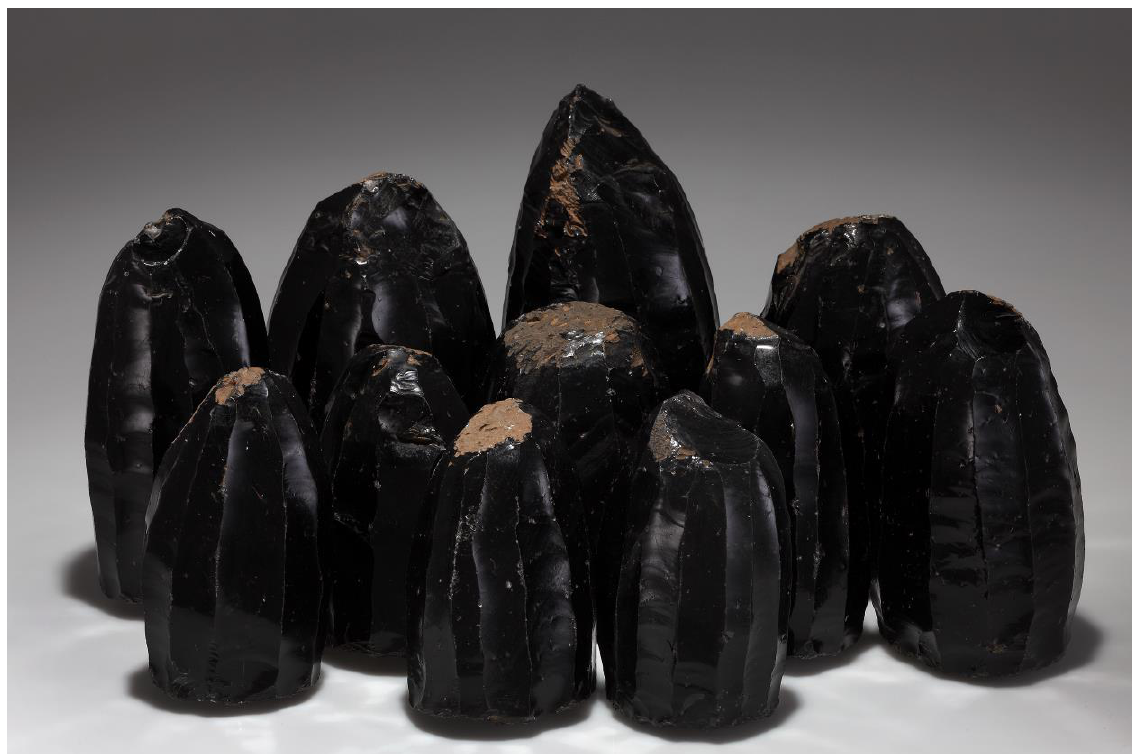
Figure 1. Depot find of obsidian blade cores from Nyírlugos. (Photo courtesy of Judit